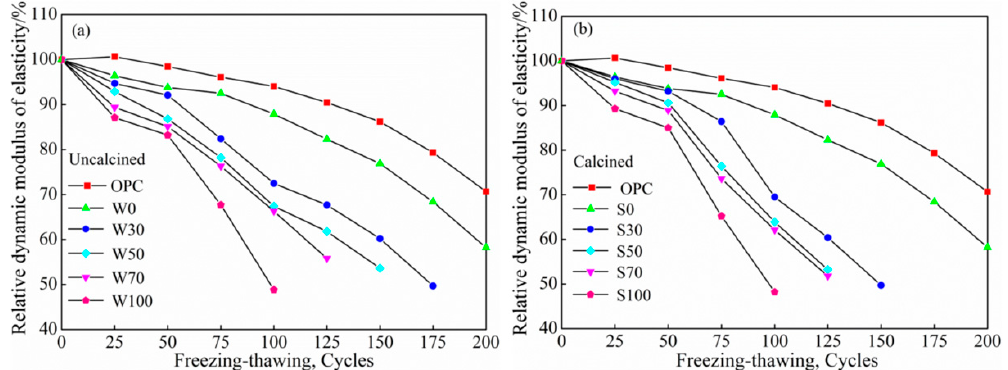
Figure 6. The relationship between the number of freezing-thawing cycles and the relative dynamic modulus of elasticity of ( a ) uncalcined and ( b ) calcined.